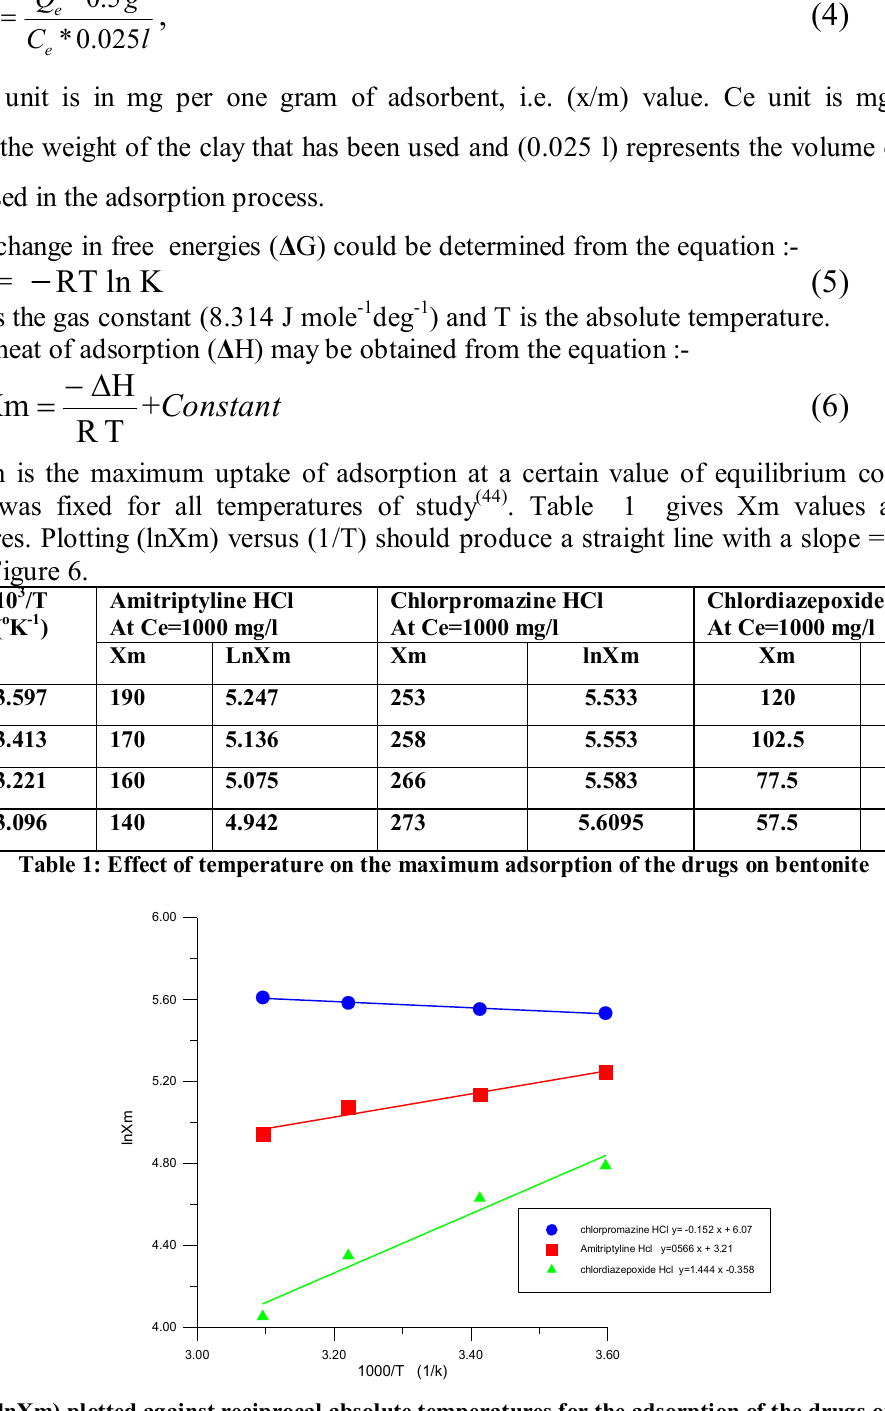
Figure 6: (lnXm) plotted against reciprocal absolute temperatures for the adsorption of the drugs on